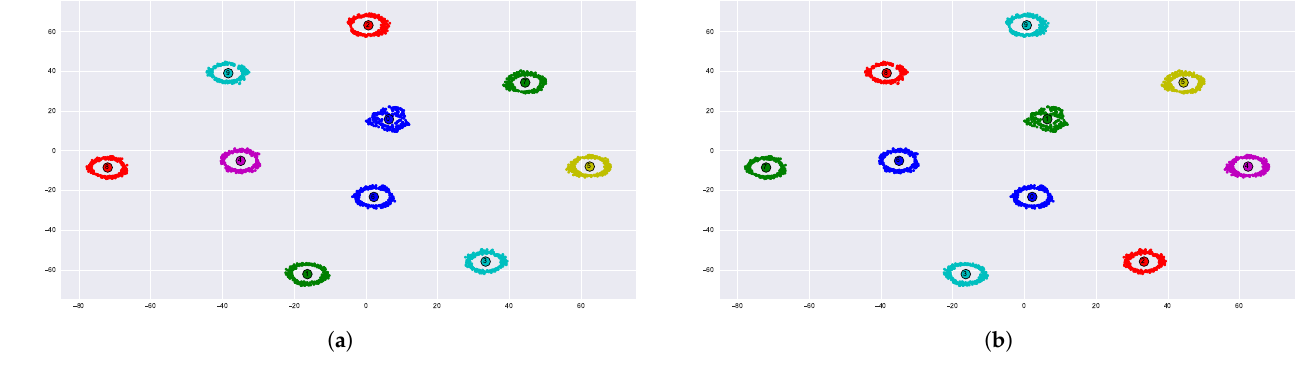
Figure 6. Estimate the number of clusters using mean-shift ( a ) and x-means ( b ).